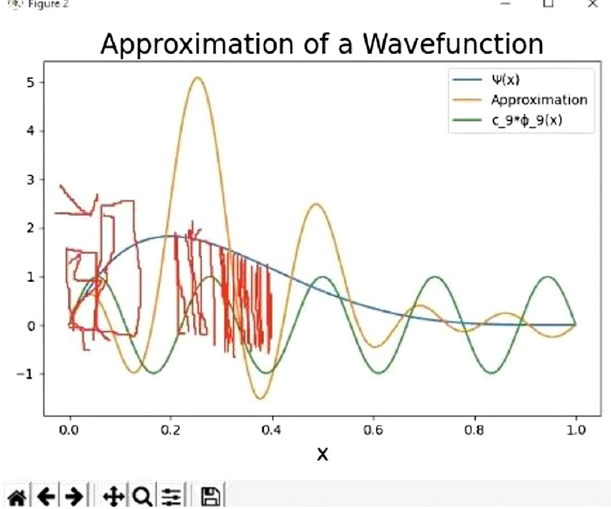
FIG. 1. Participant F used screen annotation to draw on a plot with probability density on the vertical axis and position on the horizontal axis to enhance their explanation of the role of the size of dx in a Riemann sum. The plot shows a wave function (blue) and the approximation of the wave function (blue), the ninth energy-eigenstate term of the approximation (green), and the participants Riemann sum annotation